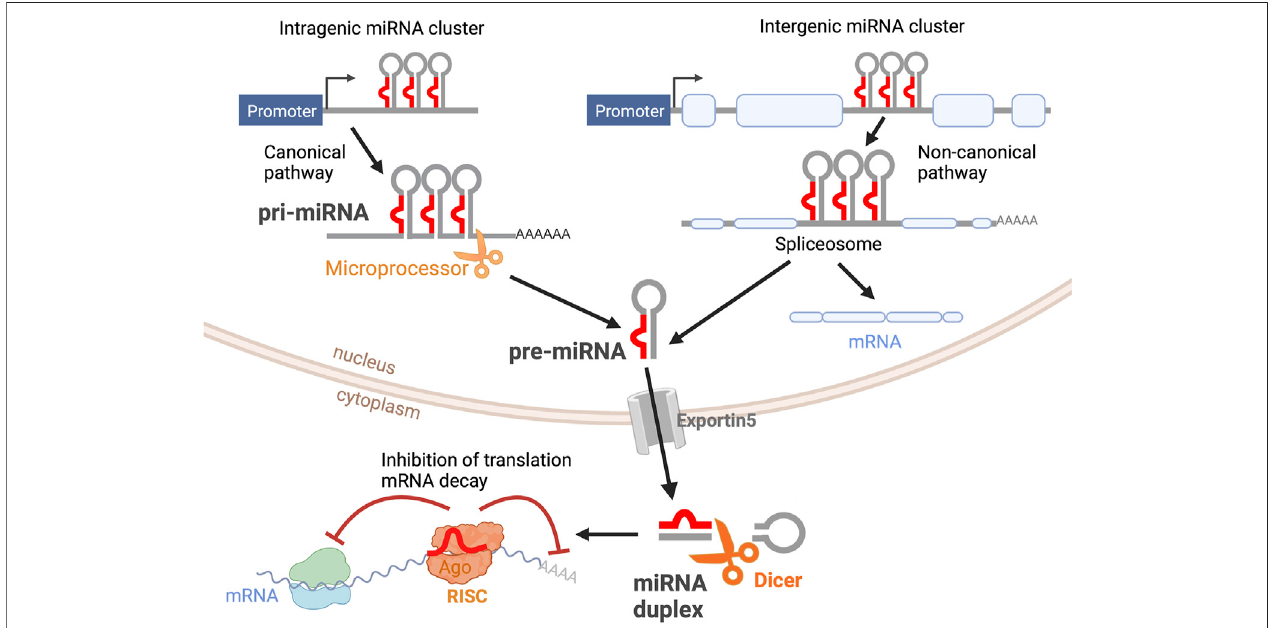
FIGURE1| miRNAbiogenesis.Primary miRNAs (pri-miRNAs)aretranscribedasdouble-stranded hairpin-like structures.Intragenicpri-miRNAsare processed via the canonical pathway, where the clusters of hairpin-like structures are cleaved into individual precursor miRNAs (pre-miRNAs) by the microprocessor complex. Intergenic pri-miRNAs are processed by the splicing machinery. The resultant pre-miRNA from both pathways is an individual hairpin-like structure of 70-nt. After being exported from the nucleus via Exportin5, pre-miRNAs are further processed by Dicer into mature miRNA duplexes. One miRNA strand is loaded into the RNA- Induced Silencing Complex (RISC). Mature miRNA binds to its target mRNA, inhibiting mRNA translation and inducing mRNA decay. This fi gure was created with